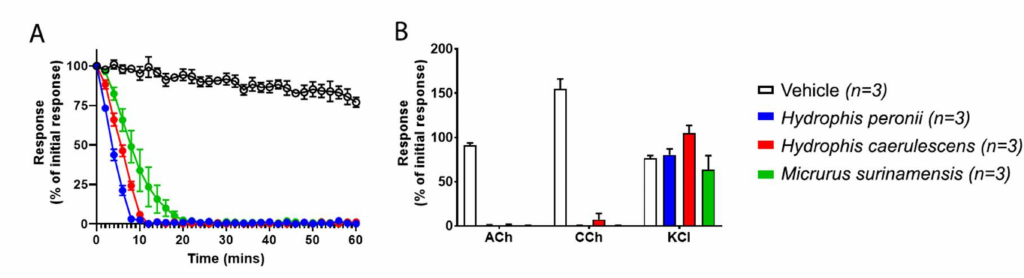
Figure 2. In vitro neurotoxicity using the chick-biventer cervicis nerve muscle preparation (CBCNM); ( A ) Inhibition of indirect twitches in the CBCNM by Hydrophis peronii (blue), H. caerulescens (red) and Micrurus surinamensis (green). Vehicle (white) is the control. ( B ) The e ff ect of venoms on the contractile response to exogenous agonists acetylcholine (ACh), carbachol (CCh), and potassium chloride (KCI). All venoms were tested in triplicate ( n =